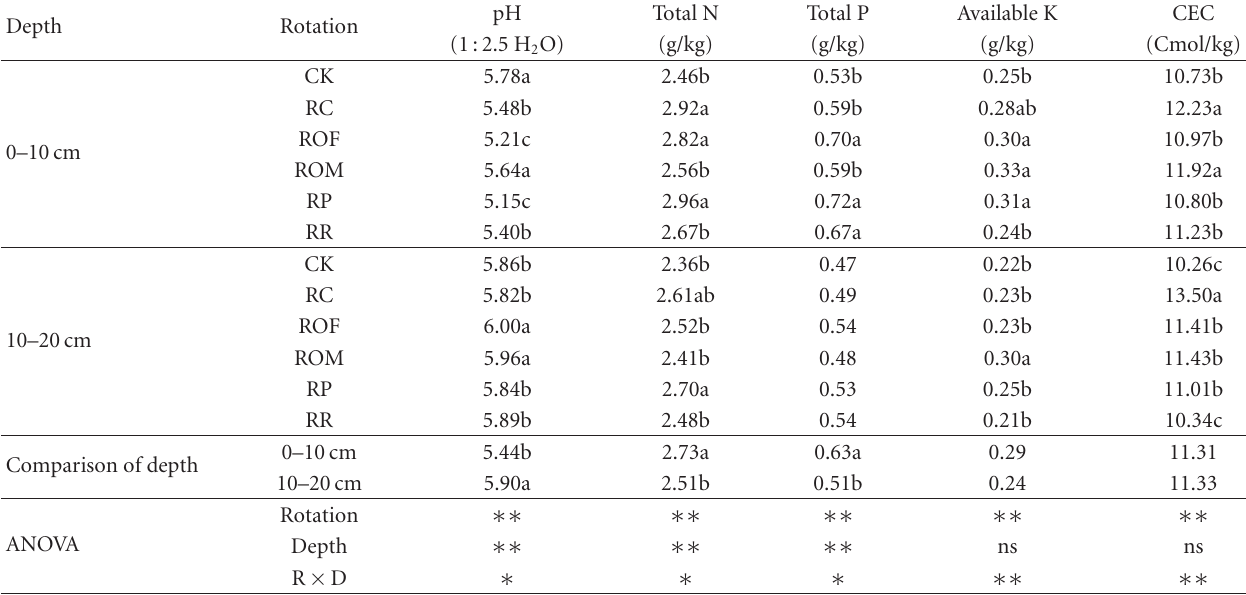
Table 4: Soil chemical properties in 0–10 cm depth.